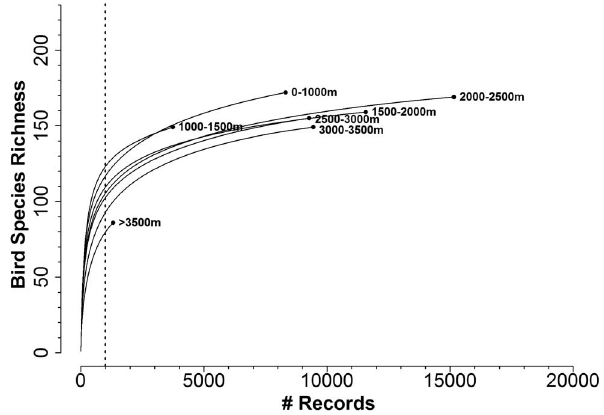
Figure 2. Example of rarefaction curves used in the analyses: Rarefaction of bird diversity by elevation. Each line represents all the records from within a given 500 m elevation band. Each curve estimates the number of species that would be encountered from a given number of bird recorded observations. The length of each line represents the total number of bird records for that elevation zone. The vertical dotted line represents the minimum threshold sample sizes used to estimate species richness so as to include all